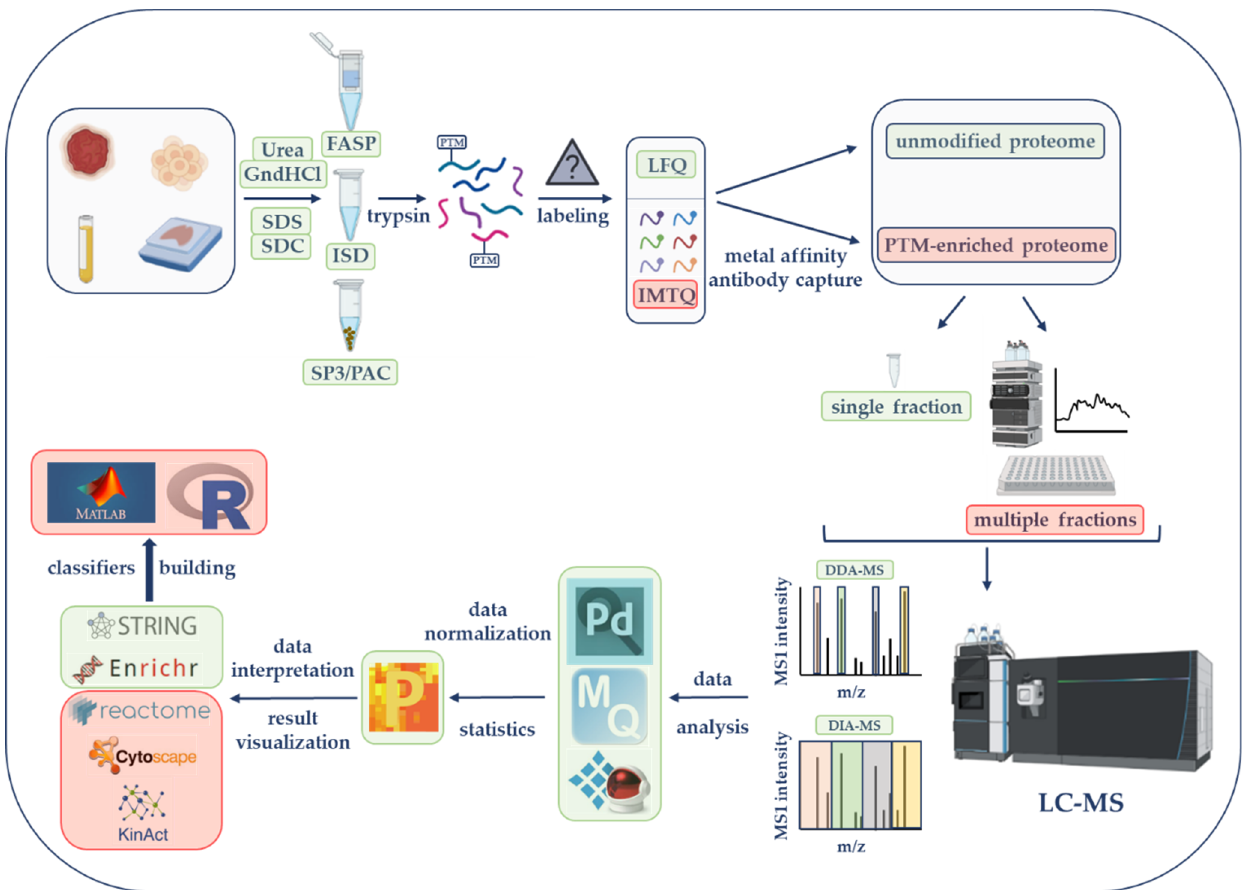
Figure 1. Liquid chromatography–mass spectrometry (LC-MS)-based proteomics workflow.